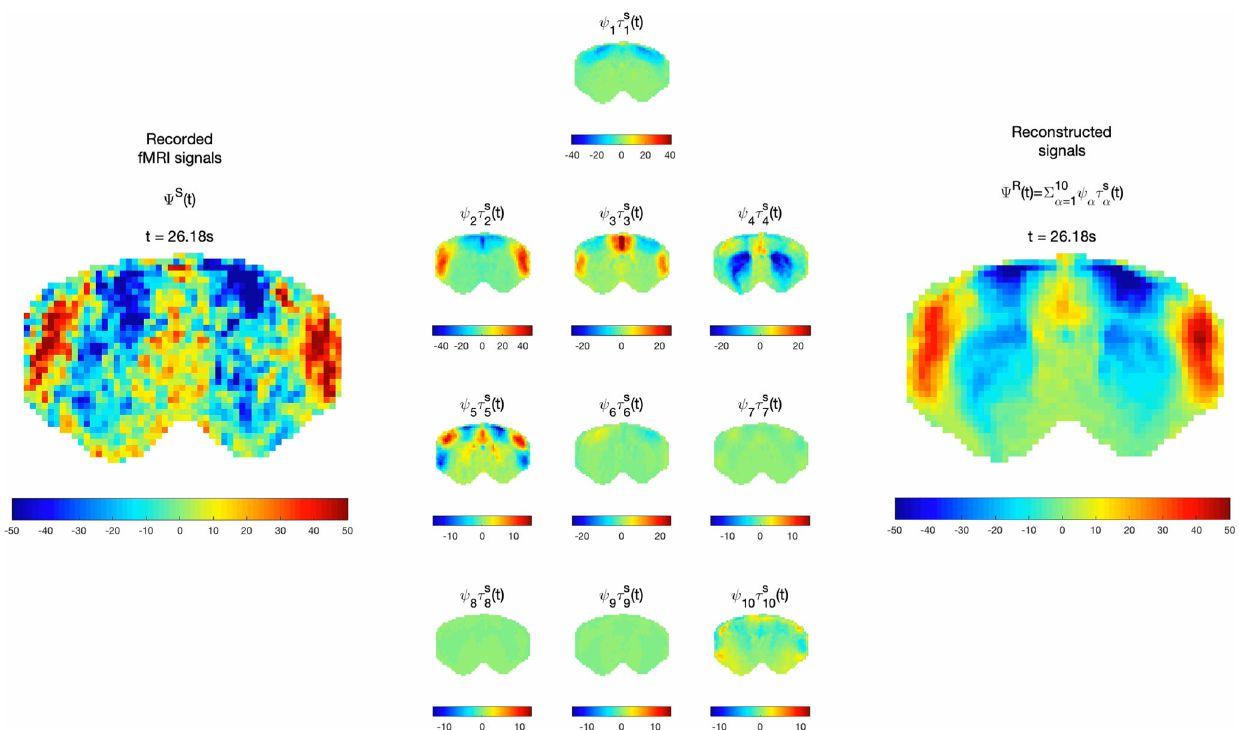
Fig. 4 | Recorded signals are reconstructed as the linear superposition of 10 condition-speci fi c principal components with scan-speci fi c temporal sig- natures. ThisimageisastillframefromSupplementaryMovie3.(Left)fMRIsignals in N =1463brainvoxelsband-pass fi lteredbetween0.01and0.3Hzrecordedfroma representative rat under medetomidine only. Middle) Each of the 10 spatially de fi ned principal modes of covariance is scaled over time by its corresponding